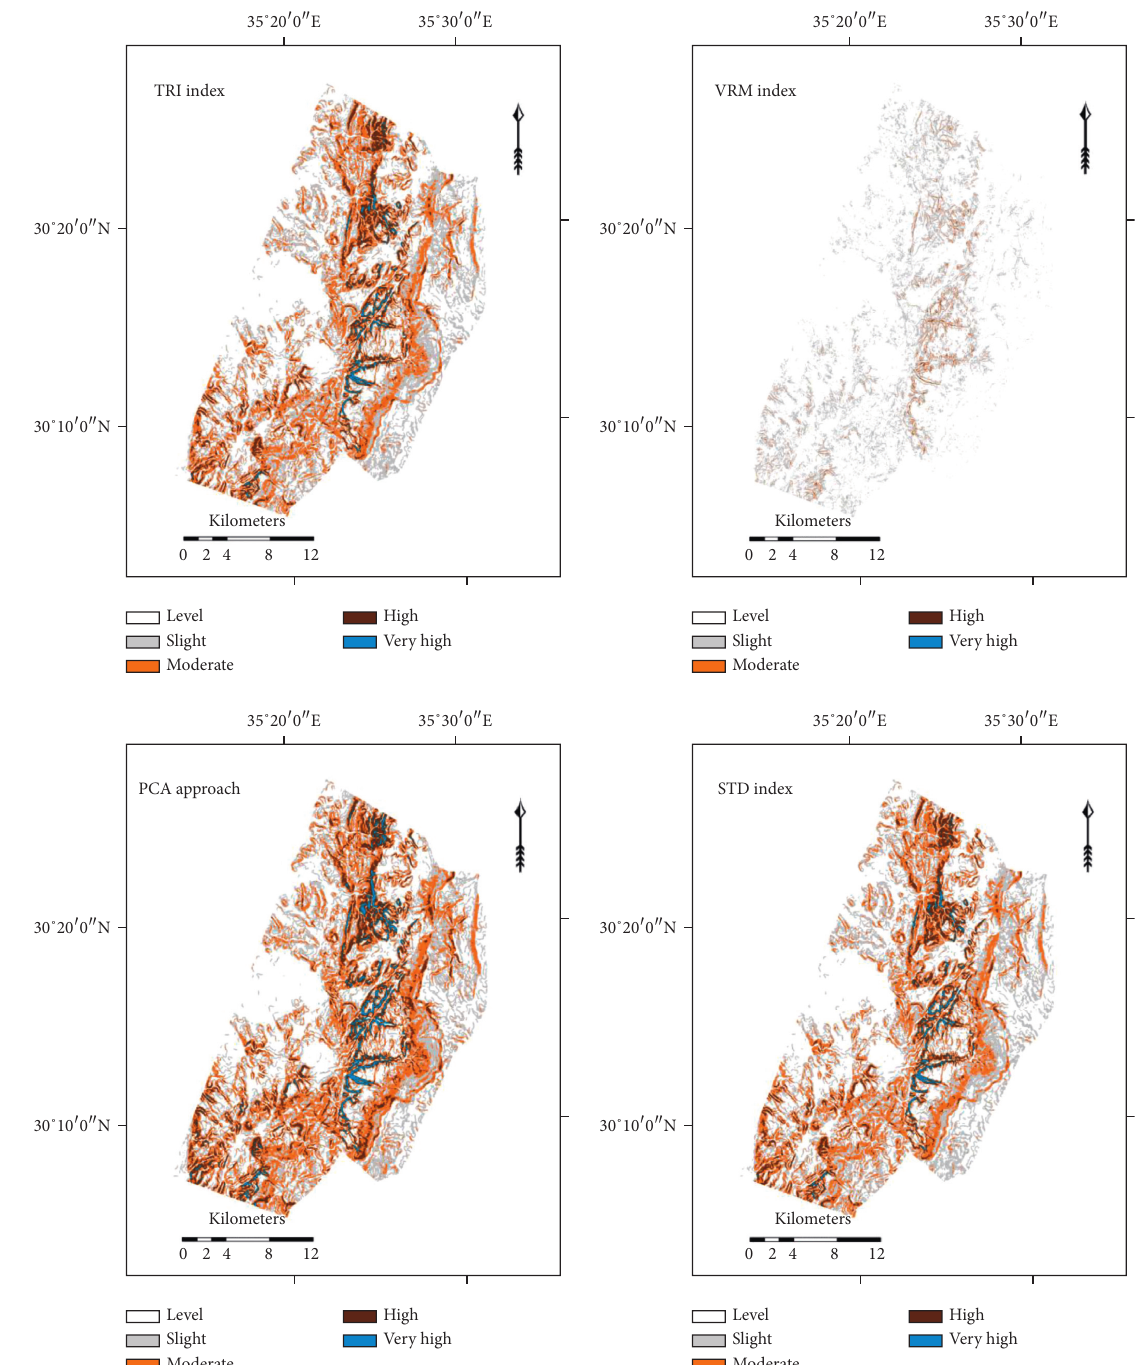
Figure 15: Topographic ruggedness maps of investigated